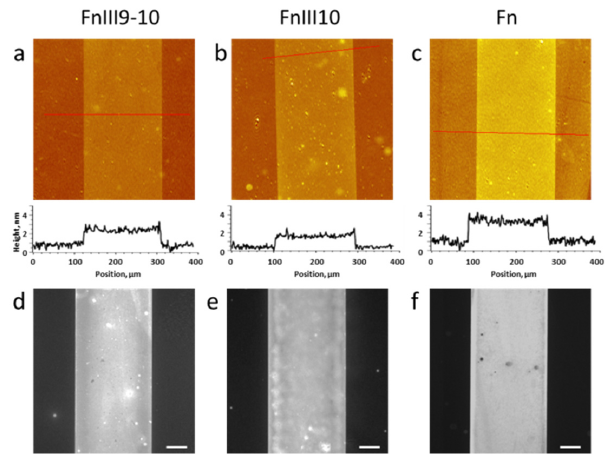
Figure 1. Visualization of FnIII9-10, FnIII10 and Fn zones formed on ultrathin PEG methacrylate hydrogel coatings. ( a – c ) Representative imaging ellipsometry thickness maps recorded in air, shown together with their respective height cross-sections. The biochip substrate was silica. ( d – f ) Fluorescence microscopy images of the same type of biochip surfaces fabricated on glass substrates, after antibody binding against the cell attachment fragment in PBS buffer. The scale bar is 50 µm. (see Materials and Methods (Section 2) for